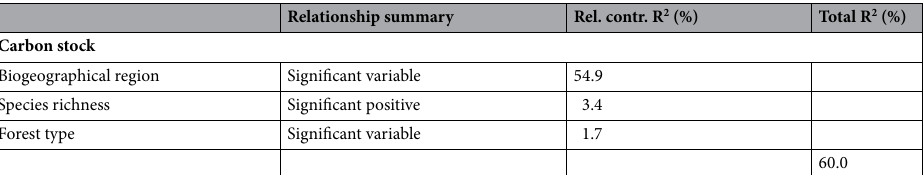
Table 2. Summary of the optimized multiple linear model of carbon stock predicted by species richness and environmental covariables across the Amazonia dataset (n = 283 1-ha plots). Originally included predictors were species richness, forest type and biogeographical region. For each predictor, a summary of the relationship and the relative contribution to total model R 2 (%) is given. Model details included in Table